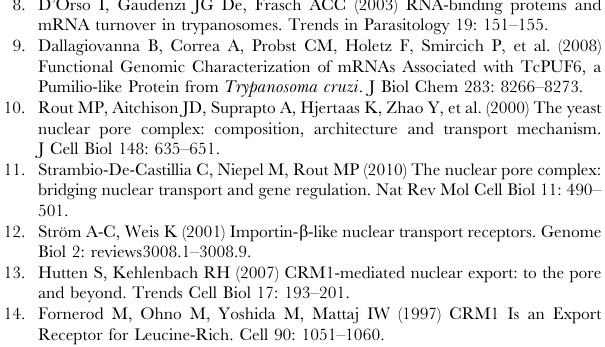
Figure S2 Localization of polyadenylated mRNA after induction of RNAi against Mex67 in T. brucei. Cellular localization of mRNA with a digoxigenin-conjugated oligo(dT) probe, by fluorescence in situ hybridization (FISH). The probe was detected by indirect immunofluorescence assays with a mouse anti-digoxigenin monoclonal antibody (Sigma-Aldrich, 1:300 dilution) followed by a secondary Alexa Fluor 488-conjugated antibody. As a control, 100 m g/ml RNase A was incubated with the parasites before probe hybridization (RNase A). DAPI= DNA stained with DAPI. MERGE= merged images for DAPI staining and FISH. N= nucleus. K= kinetoplast. Bar= 5 m m.